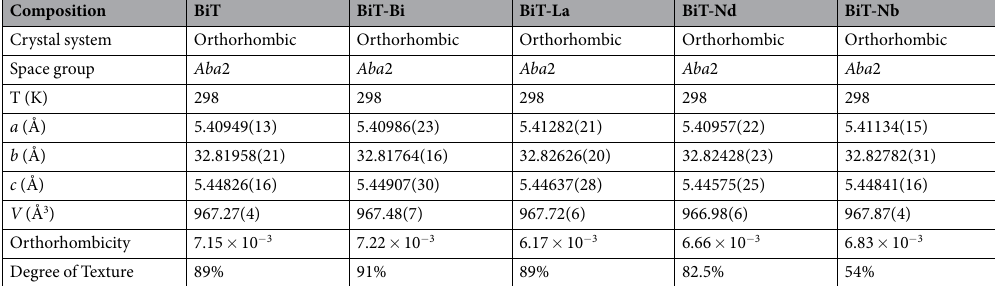
Table 1. Crystal data, lattice parameters ( a , b , c ) and unit cell volume ( V ) of BiT, BiT-A and BiT-Nb, whose orthorhombicity is defined as 2( c − a )/( c + a